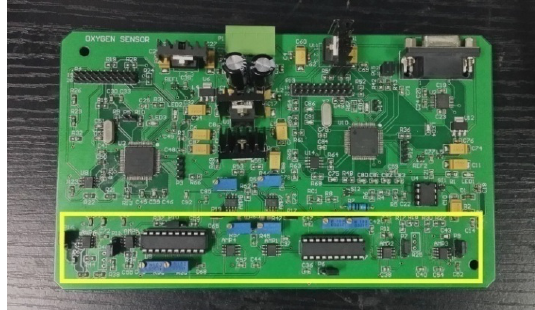
Fig. 4 Photo of fabricated oxygen detection system: the designed lock-in amplifier is under the picture, delimited by the solid line.